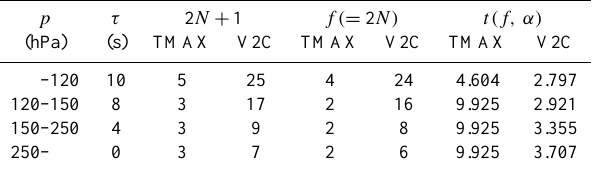
Table 2. Response time, τ , empirically determined for frostpoint hygrometers and the number of averaging, 2 N + 1, applied to the raw sonde data to derive smoothed frostpoint temperature profiles. t values corresponding to the significance level α = 0 . 005 are also shown. See text for the